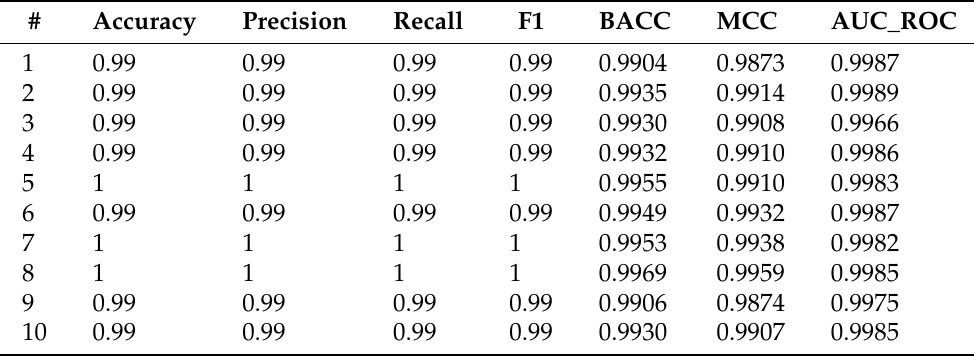
Table 7. Summary of the results for the deep neural